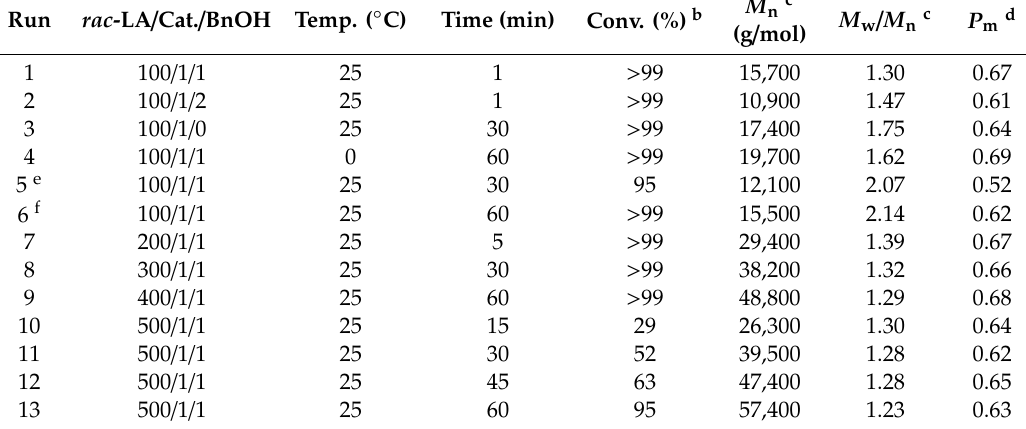
Table 1. The isoselective ring ‐ opening polymerization of rac ‐ lactide using DiPh ‐ TBD a . rac ‐ Temp. Run LA/Cat./BnOH